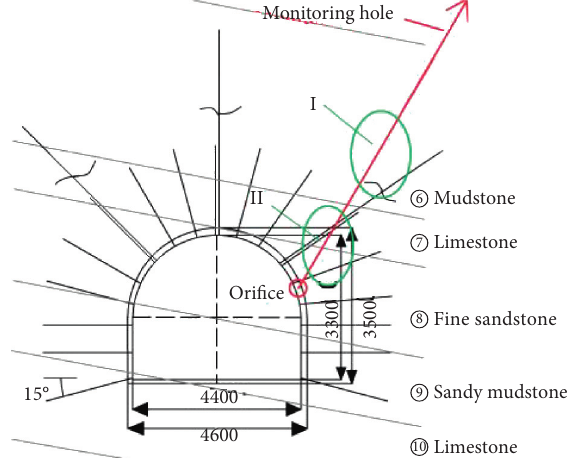
Figure 6: Sectional view of the corresponding relationship between the supporting structure of floor gas drainage roadway and the